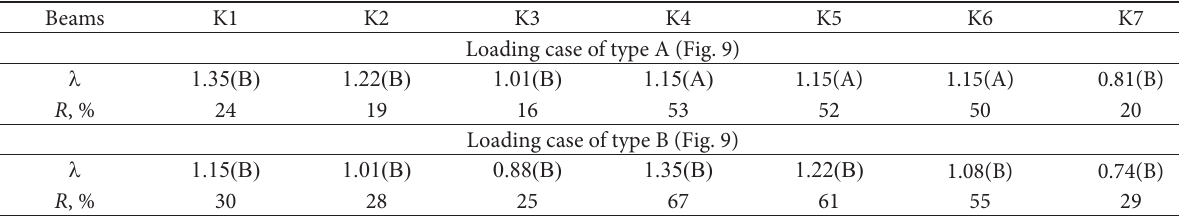
Table 8. Hogging and sagging bending (kNm) – See Table 4 (class 4) – All options – Local buckling included Beams